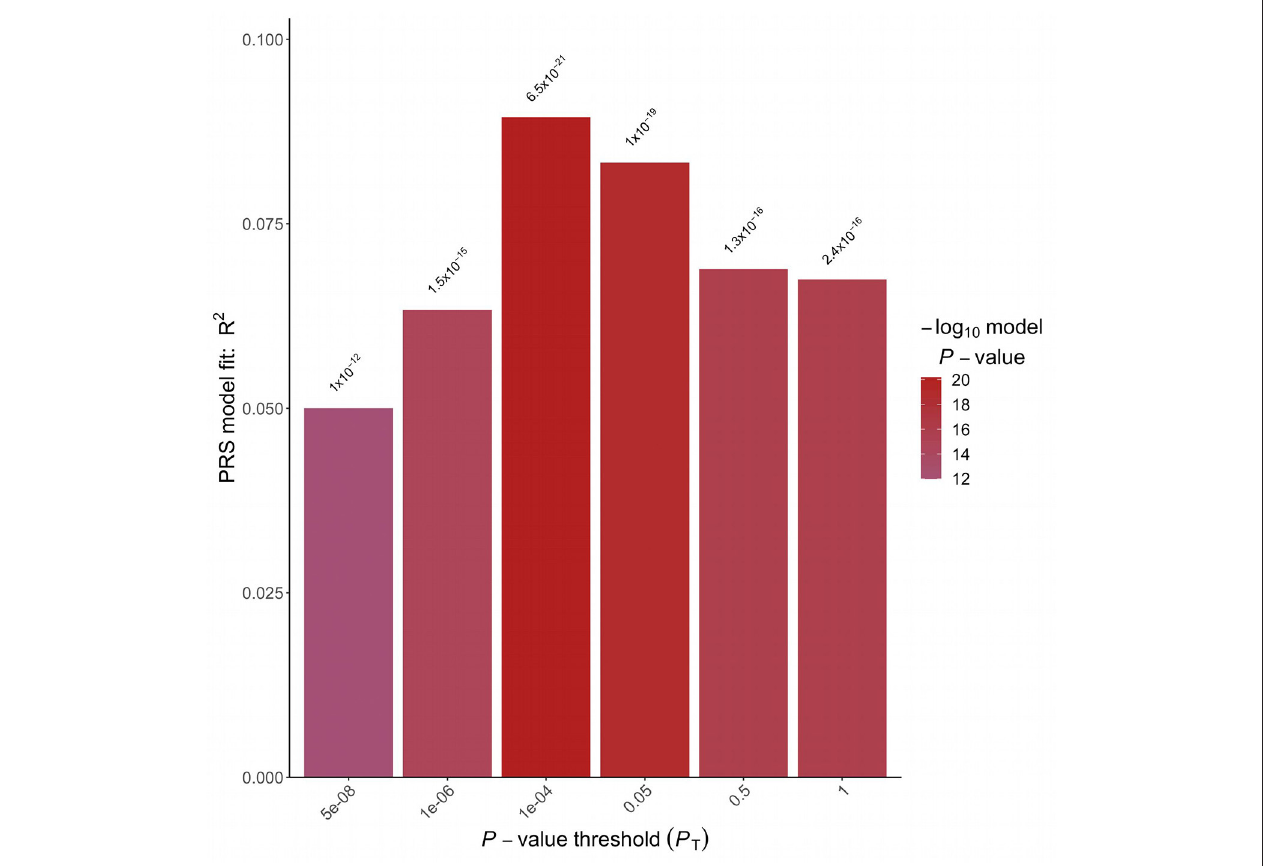
FIGURE 2 | Polygenic risk score analysis. Bar plot displaying the model fit of the PRS at P-value threshold. In the x-axis are reported the P -value thresholds used to filter for the variants to be included in the PRS computation. Above the bar are reported the P -values of the logistic association test.